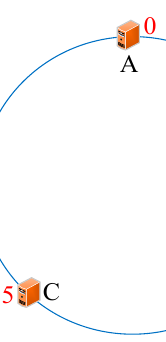
Figure 6. The mapping of servers to the hash circle.